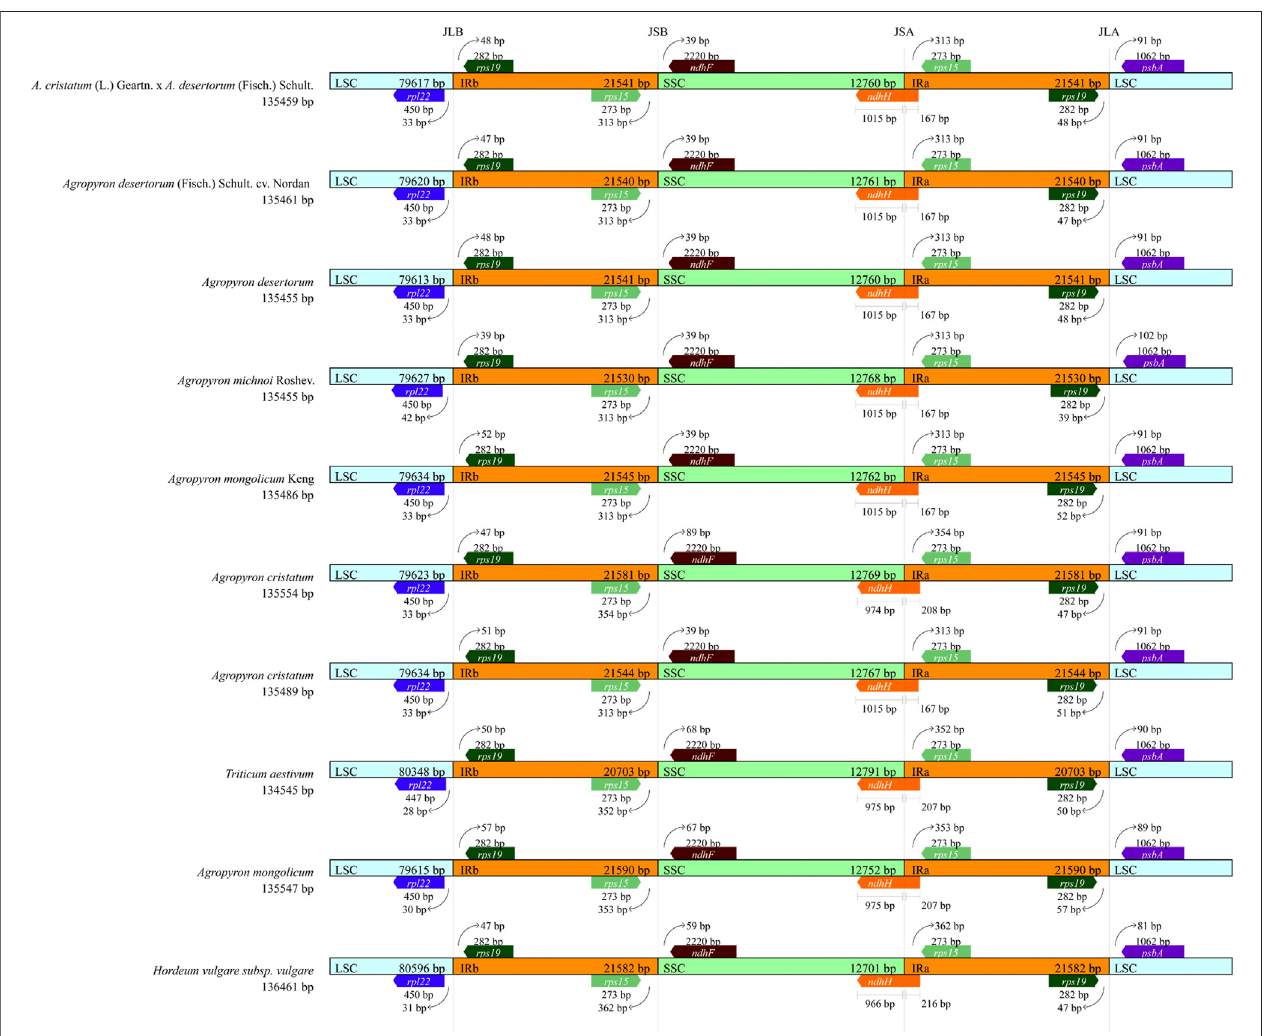
FIGURE8| AnalysisofIRboundarychangesofchloroplastgenomes.Thethinlinesrepresenttheconnectionpointsofeachregion,andthemapshowsinformation about the genes near the connection points.